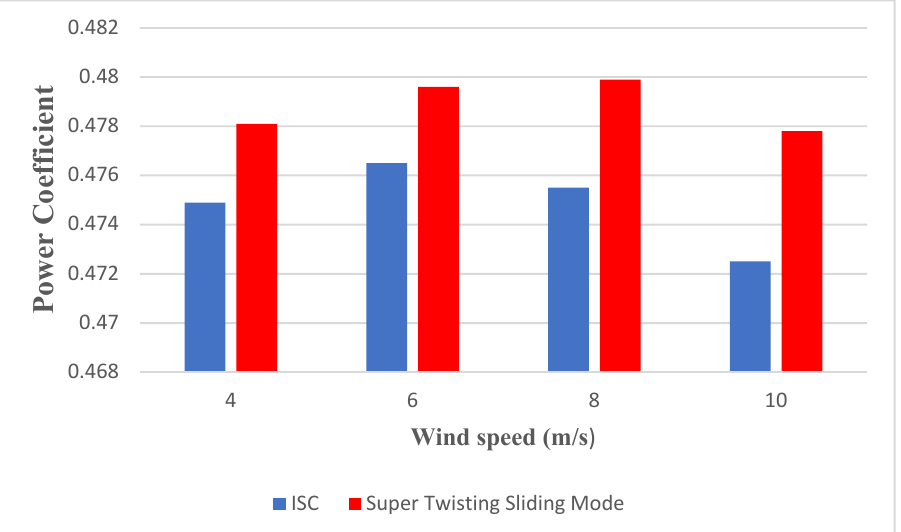
Figure 16. Comparison between ISC control approach and Super twisting sliding mode control in absorbing wind energy in different mean wind speed values with turbulence intensity 10%. Blue is the power coefficient of ISC and red is the power coefficient according to the super twisting sliding mode control approach.